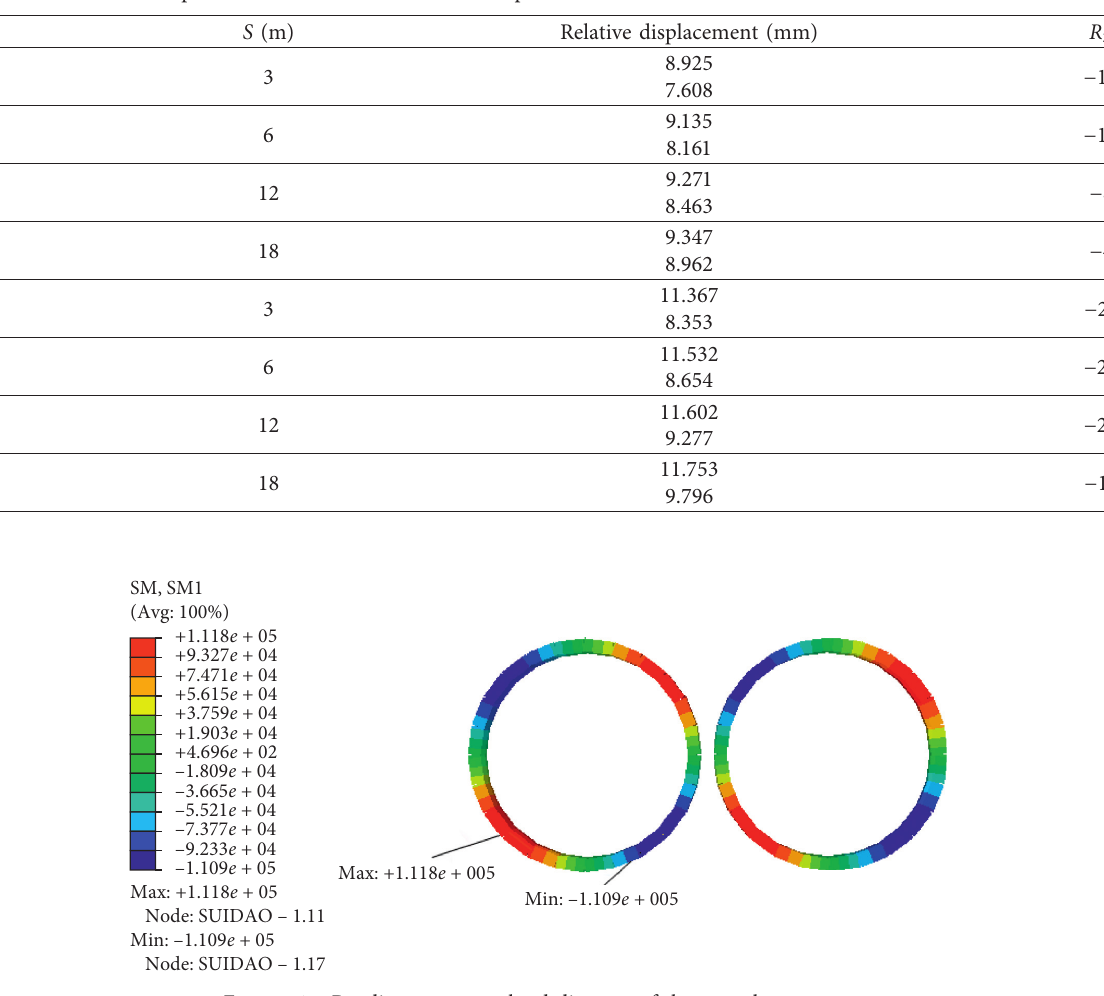
Table 9: Displacement difference between the top and bottom of the tunnel under various conditions.